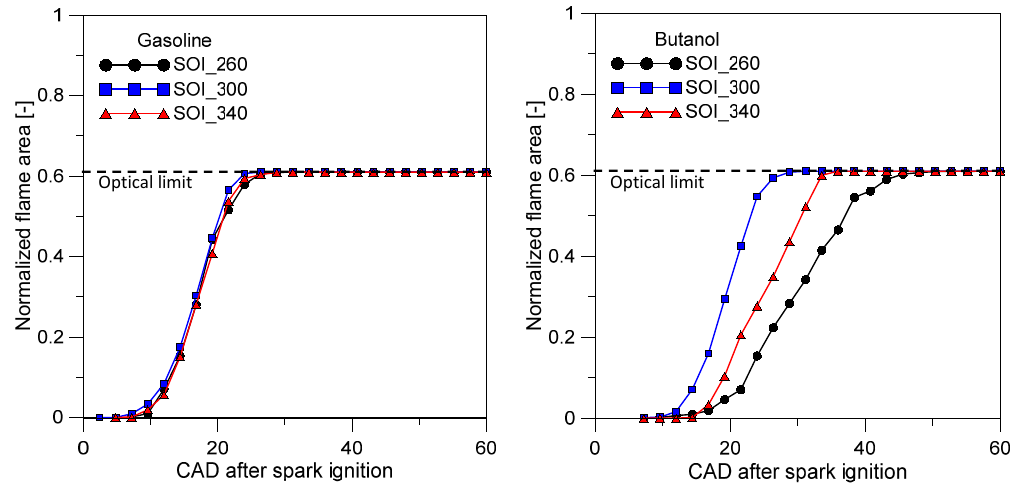
Figure 8. Evolution of the flame front area for the two fuels.